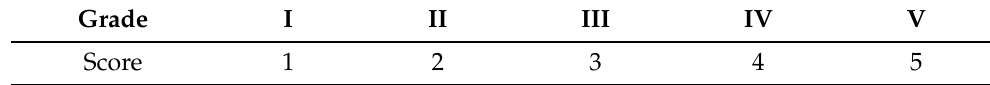
Table 12. Evaluation grade